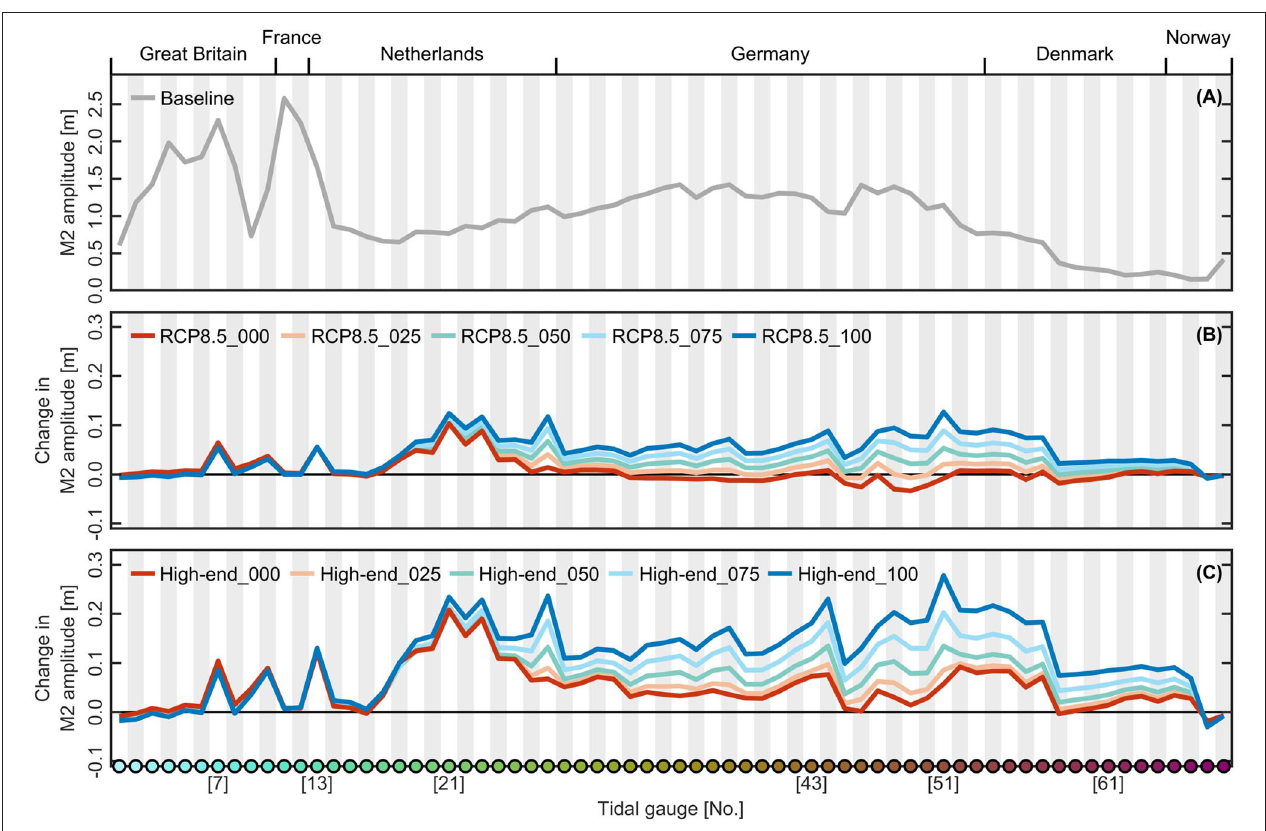
FIGURE 8 | M2 amplitudes as a function of available tidal gauge stations resulting from the combinations of different SLR projections and various cumulative rates of vertical accretion. (A) M2 amplitudes for the baseline scenario, according to the 3-month period from September 1 to December 1, 2012. (B) Relative changes in M2 amplitudes resulting from 0.8m SLR and various cumulative rates of vertical accretion. (C) Relative changes in M2 amplitudes resulting from 2.0m SLR and various cumulative rates of vertical accretion. The color codes and locations of tidal gauge stations are shown in Figure 1 . Shown numbers indicate exemplary tidal gauge stations that were highlighted in more detail in Figure 2